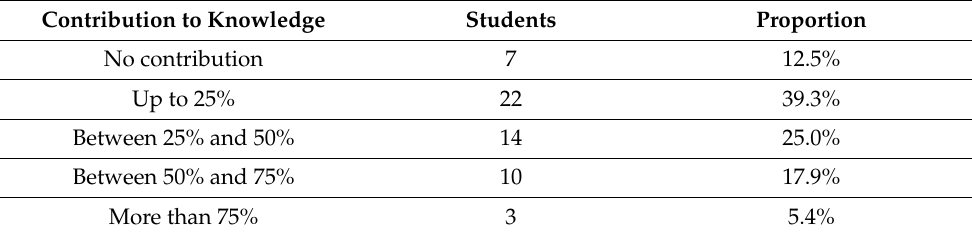
Table 7. Contribution of VRE to student